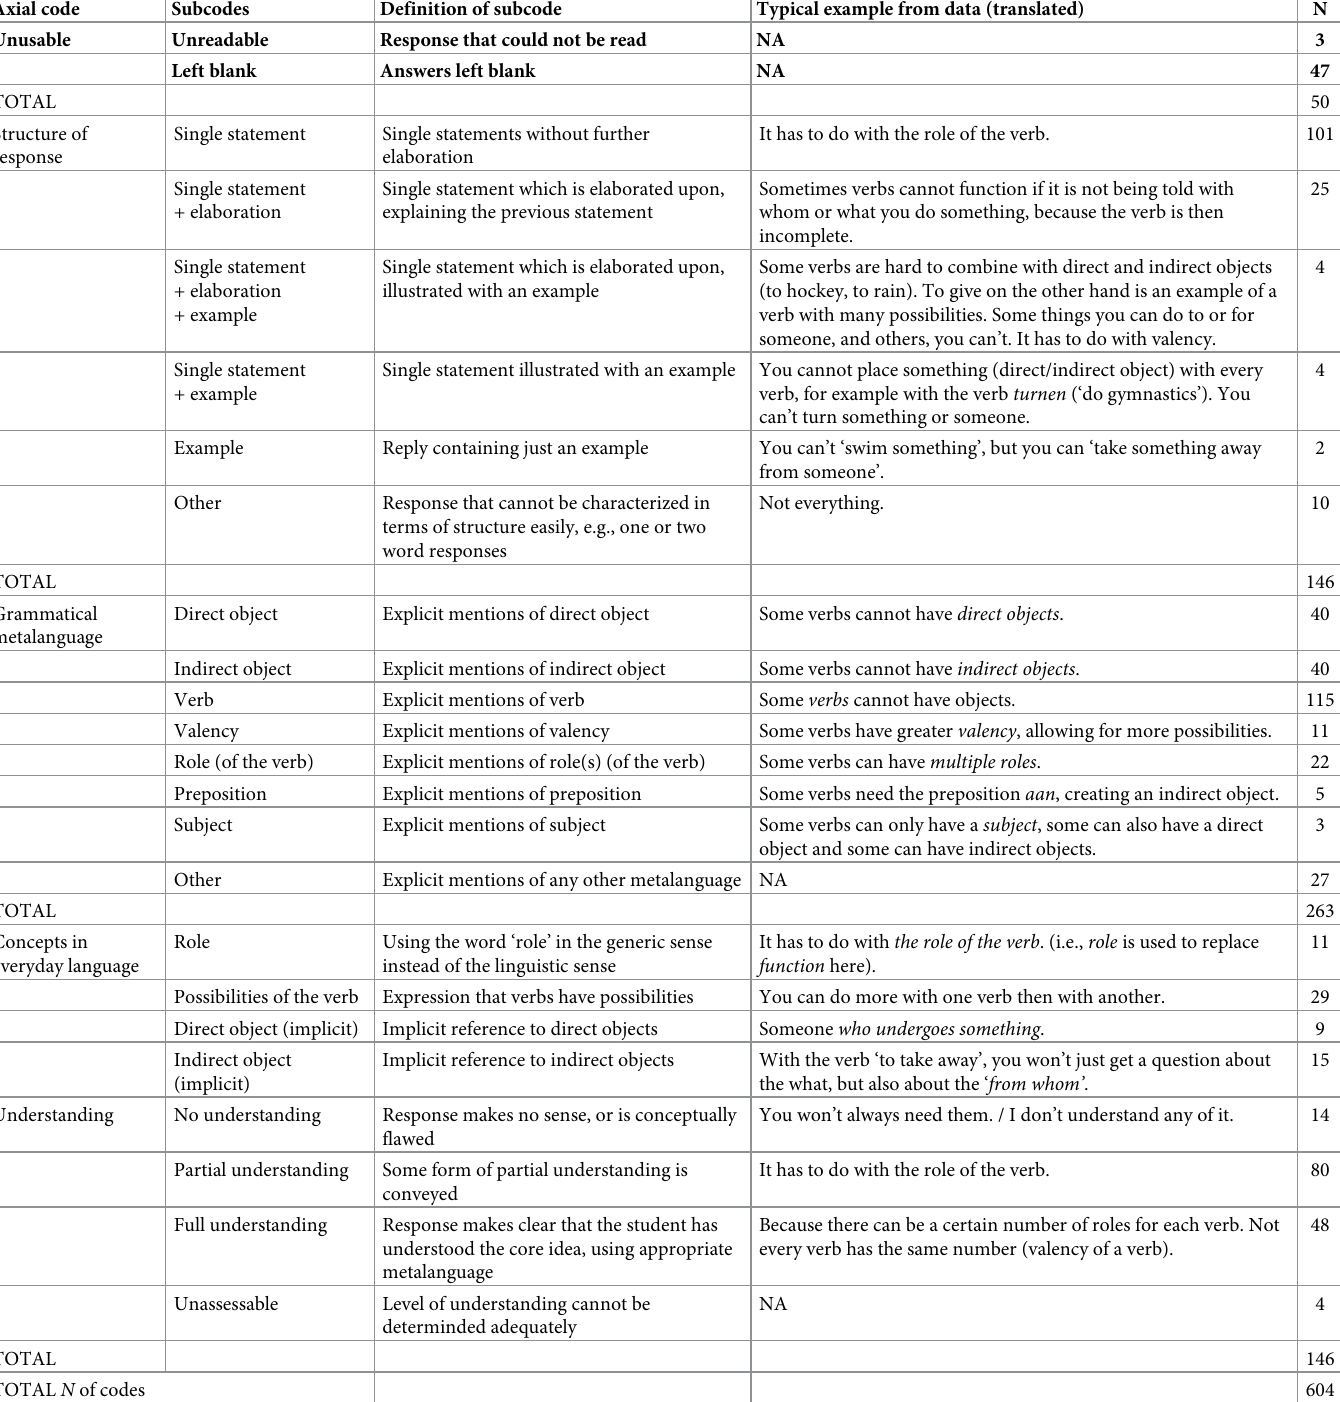
Table 5. Axial codes and subcodes related to key assigment 1 (N = 196 students; N = 146 performed and readable tasks). Axial